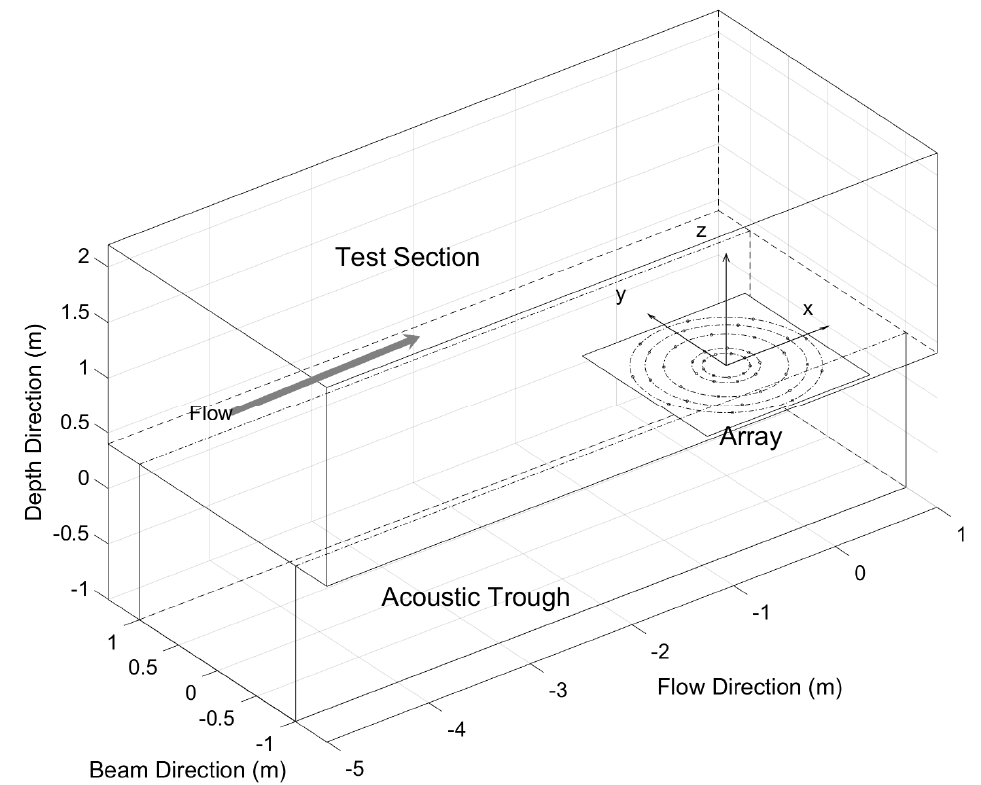
Figure 2. Forty five-channel hydrophone array configuration inside the acoustic trough.